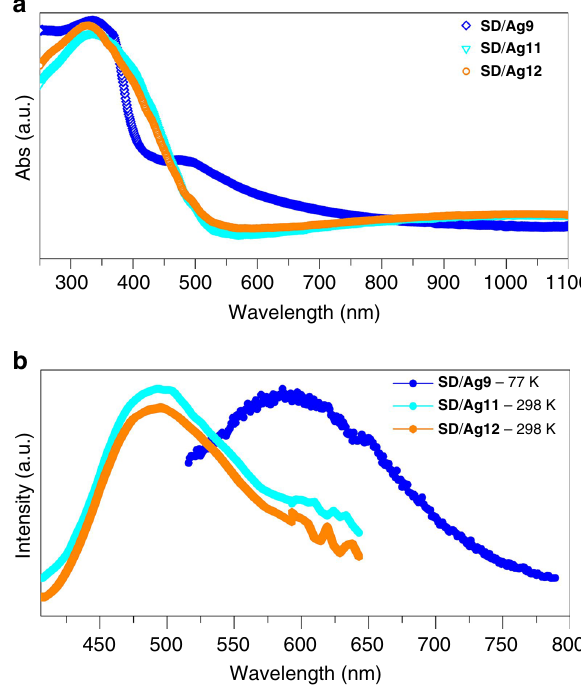
Fig. 8 The spectral properties of SD/Ag9 , SD/Ag11 and SD/Ag12 . The solid-state UV – Vis ( a ) and emission spectra ( b ) of the clusters SD/Ag9 , SD/Ag11 and